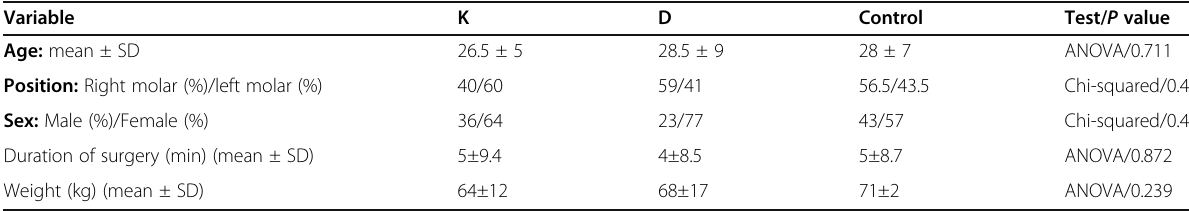
Table 1 Personal and surgical data